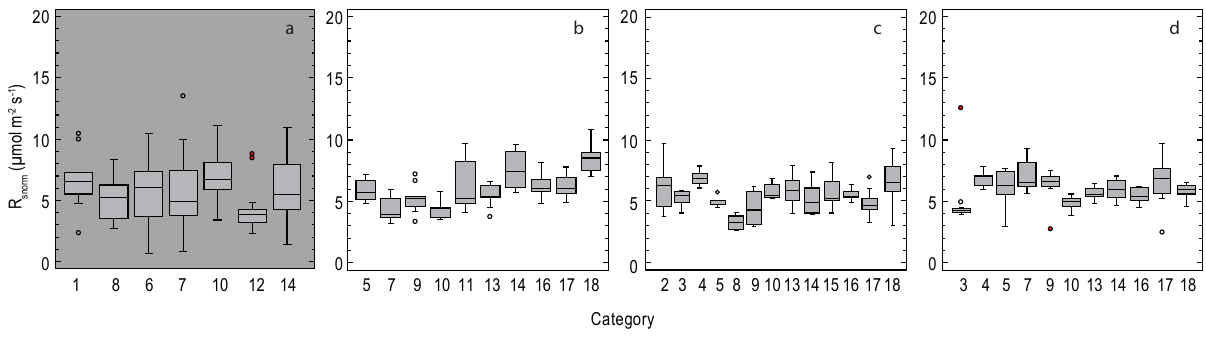
Fig. 5. Differences in subplot efflux rates in 2009 shown for each inventory plot ( a–d representing plot 1–4). Average efflux rates deviated strongly between subplots. On the contrary, efflux rates of different subplots between plots showed similar values and vice versa. Variation in subplot specific efflux rates was highest in the disturbed plot 1 (a) . Categories are given according to Tables 1 and